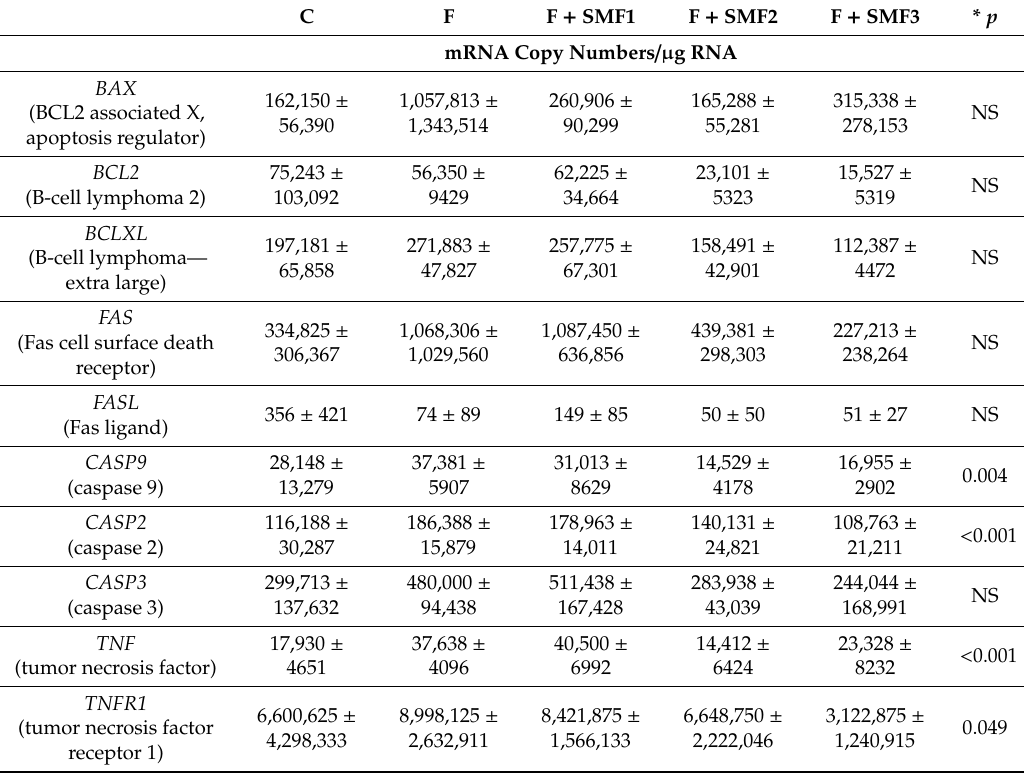
Table 2. The expression of the genes that are associated with the apoptosis process in fluoride-treated fibroblasts and in fibroblasts that had been treated with fluoride, and then subjected to the influence of SMFs of di ff erent intensities (0.45, 0.55, and 0.65 T) for 12 h compared to the control culture without fluoride and without the magnet (flux density 0.0